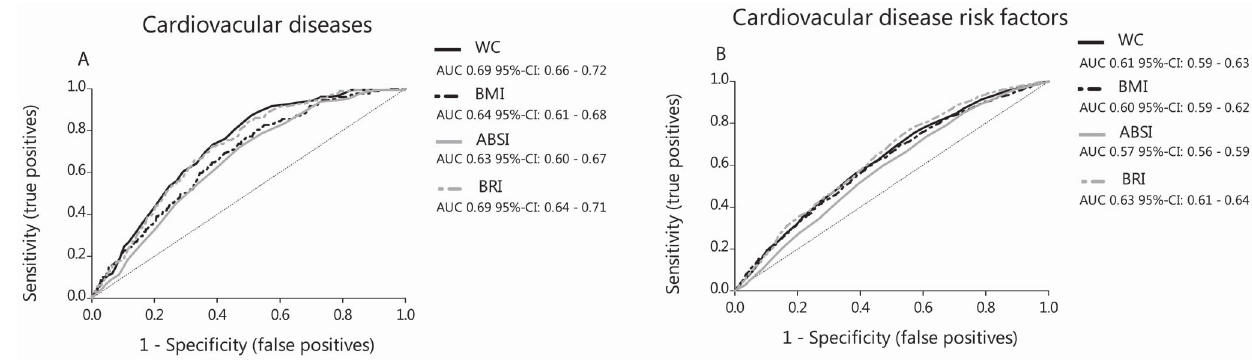
Figure 3. The discriminatory power of ABSI, BRI, BMI, and WC between subjects with or without CVD or CVD risk factors. A. Area under the Receiver Operating Characteristic curve of ABSI, BRI, BMI, and WC to identify subjects with cardiovascular diseases. B. Area under the Receiver Operating Characteristic curve of ABSI, BRI, BMI, and WC to identify subjects with cardiovascular disease risk factors.